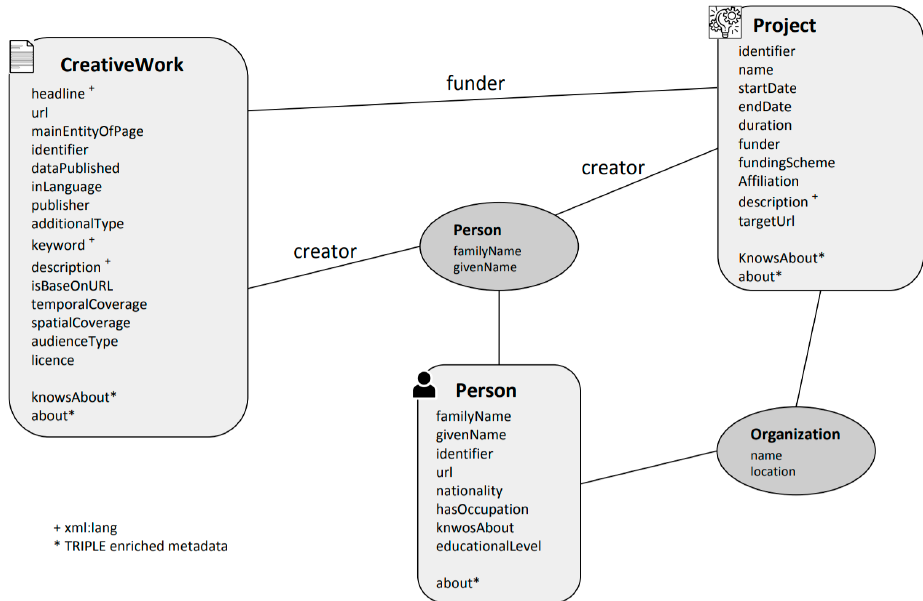
Figure 14. TRIPLE data model and linking between the 3 types of resources. Legend: “CreativeWork”